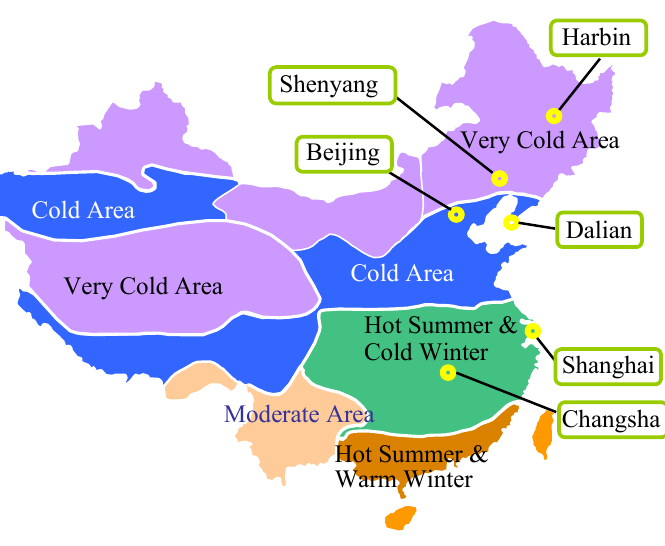
Figure 1. Location of the field measurement.